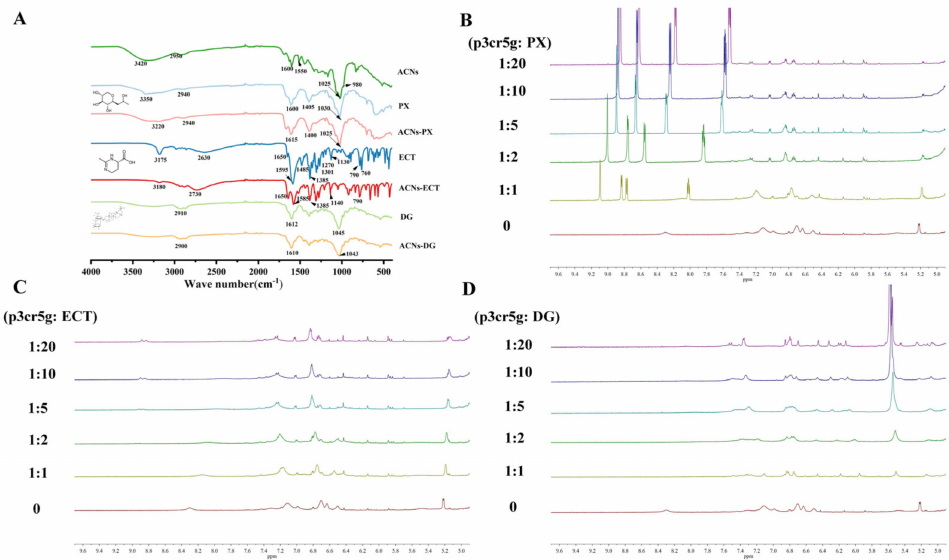
Figure 4. The spectrum of anthocyanin complex. ( A ) FTIR spectra of anthocyanin complex; ( B ) 1 H NMR spectra of petunidin − 3 − O − coumaroylrutinoside − 5 − O − glucoside − Pro − Xylane (p3cr5g − PX) at different molar ratios; ( C ) 1 H NMR spectra of petunidin − 3 − O − coumaroylrutinoside − 5 − O − glucoside − Ectoine (p3cr5g − ECT) at different molar ratios; ( D ) 1 H NMR spectra of petunidin − 3 − O − coumaroylrutinoside − 5 − O − glucoside − Dipotassium glycyrrhizinate (p3cr5g − DG) at different mo- lar